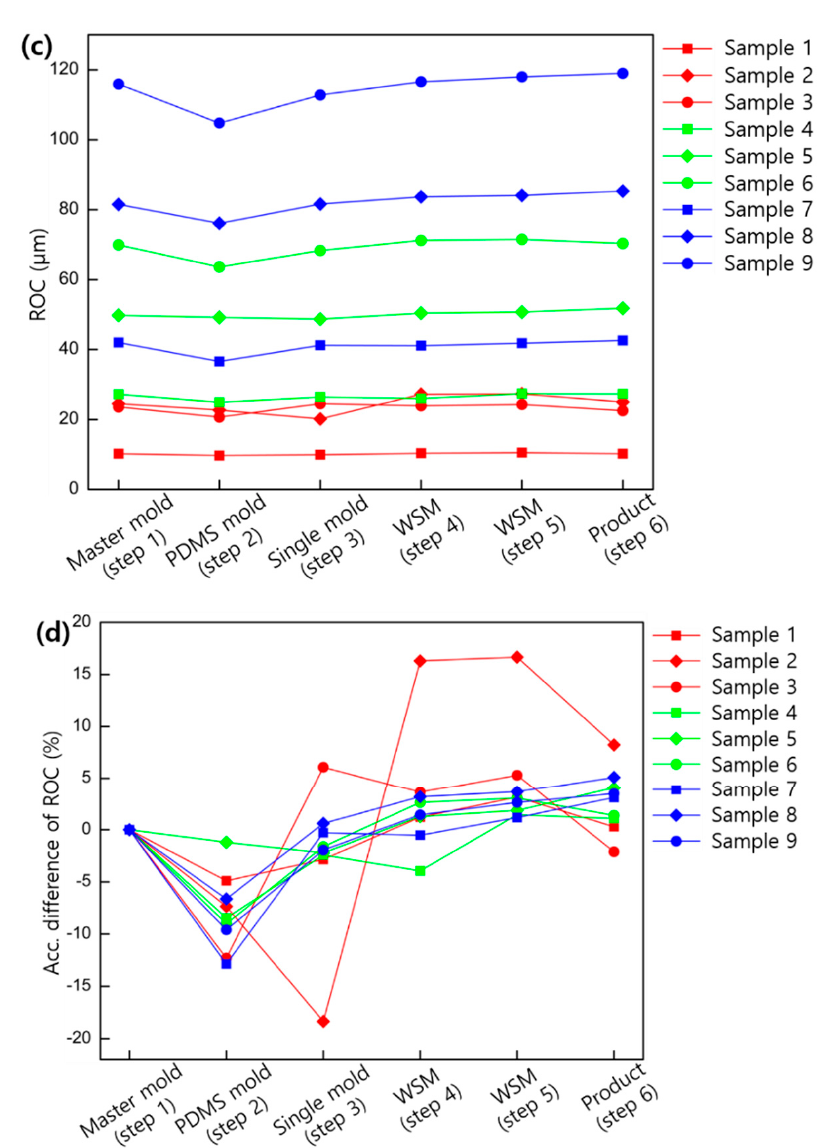
Figure 7. ( a ) Sag profiles of every sample at each replication step from the master mold to the final product. ( b ) The accumulated difference in sag in percent at each replication step. ( c ) ROC of lens variances at each replication step. ( d ) The accumulated difference of ROC in percent at each replication step.